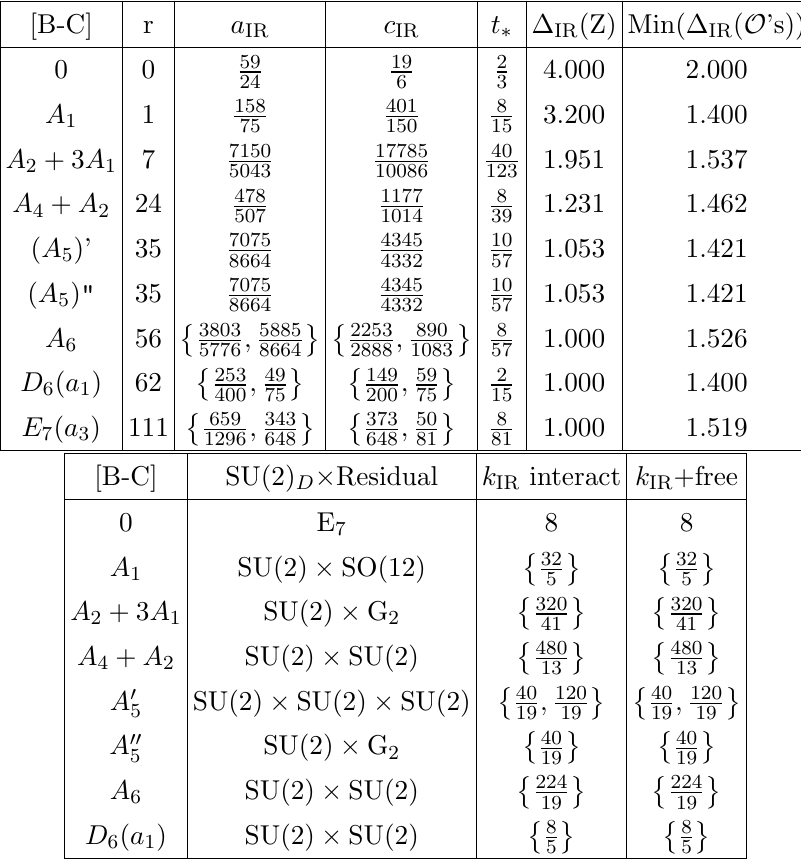
Table 12. Plain nilpotent mass deformations of the Minahan-Nemeschansky theory with E 7 (cid:13)avor, only rational values. The top table has the central charges a IR and c IR as well as scaling dimensions while the table below contains the information about the (cid:13)avor central